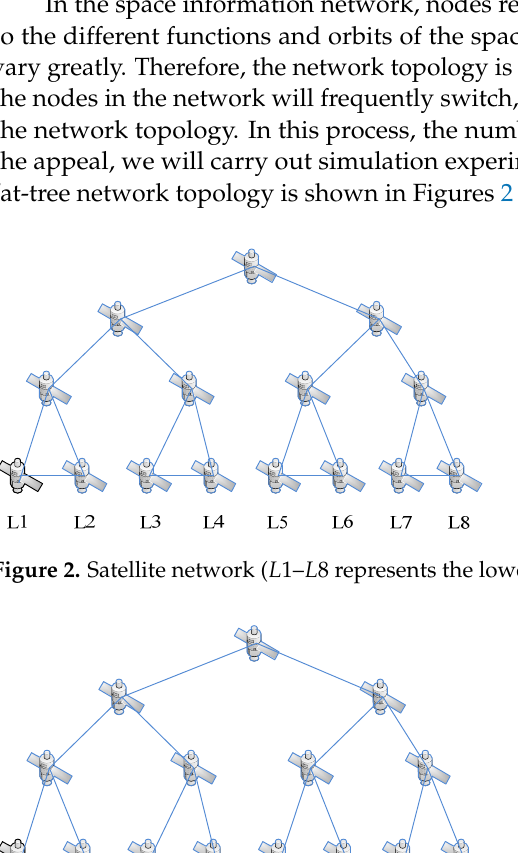
Sensors 2023 , 23 , x FOR PEER REVIEW